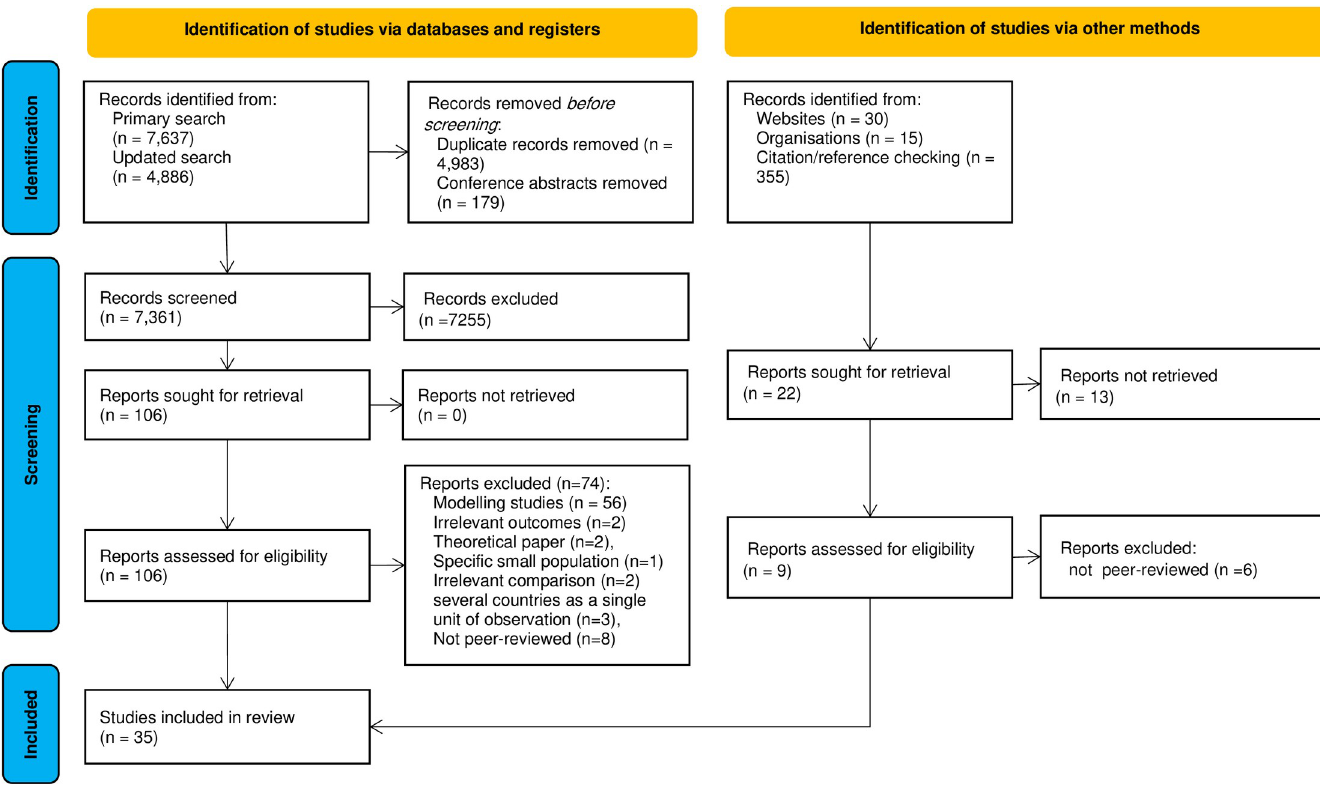
Fig 1. PRISMA flow diagram for systematic